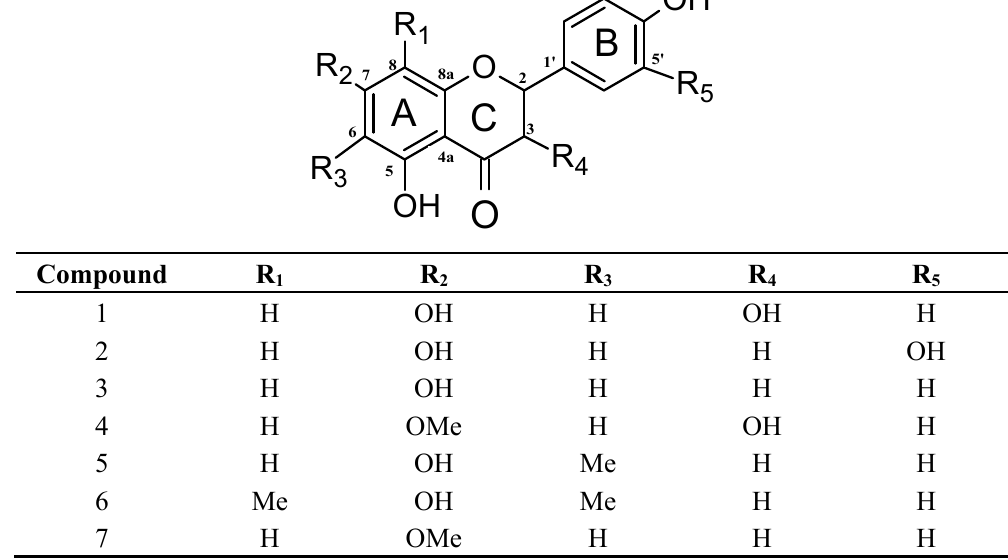
Figure 2. Structures of isolated flavanones ( 1 – 7 ) identified from kino of Corymbia torelliana.